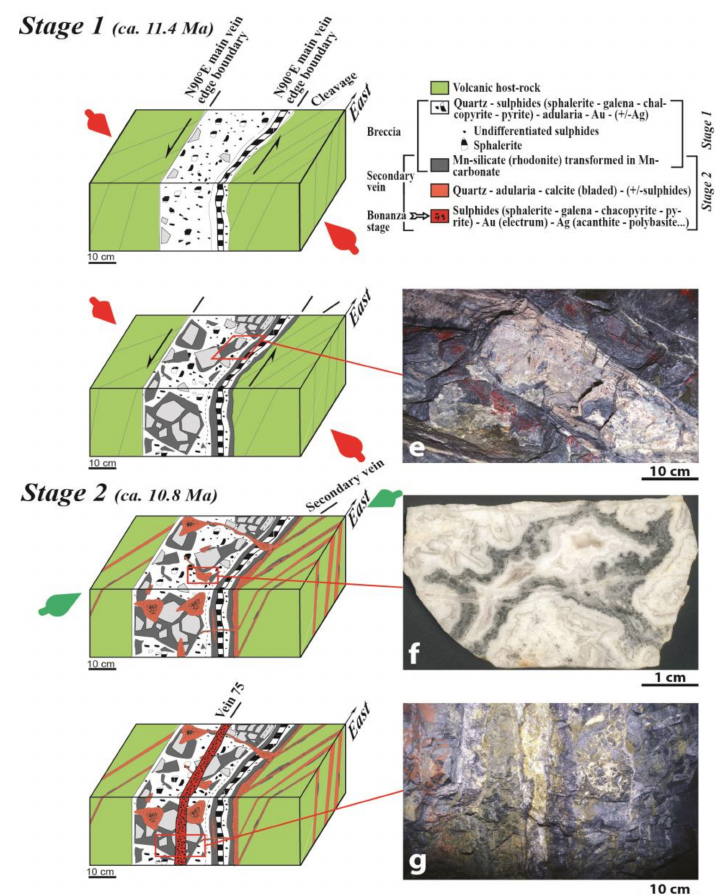
Figure 7. Example of vein formation by the re-using of pre-existing structures within the Volcanic domain of South Peru (see text for explanation). ( a ) Formation and filling of sinistral shear zone and creation of associated cleavage under the effect of NE–SW shortening direction (red arrows). ( b ) Formation of Mn-rich breccia under the same shortening direction. ( c ) Formation of secondary veins by re-opening of the cleavage by N120 ◦ E trending shortening direction (green arrows). Formation of geodic structures filled by stage 2-related paragenesis and subsequent “bonanza” stage and richer veins (Veta 75) ( d